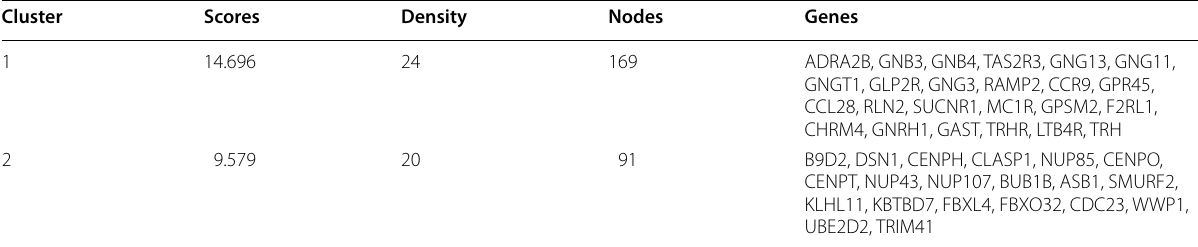
Table 5 Clusters of the PPI network of the DEGs in the non-DAU group Cluster Scores Density Nodes